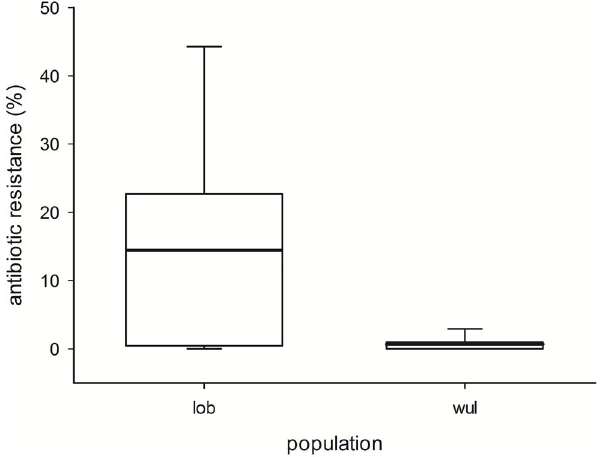
Figure 1. Proportion of antibiotic resistance in the two rook populations. The percentage of antibiotic resistance rates is significantly (p , 0.001) higher in the migrating (lob) population then in the resident (wul)